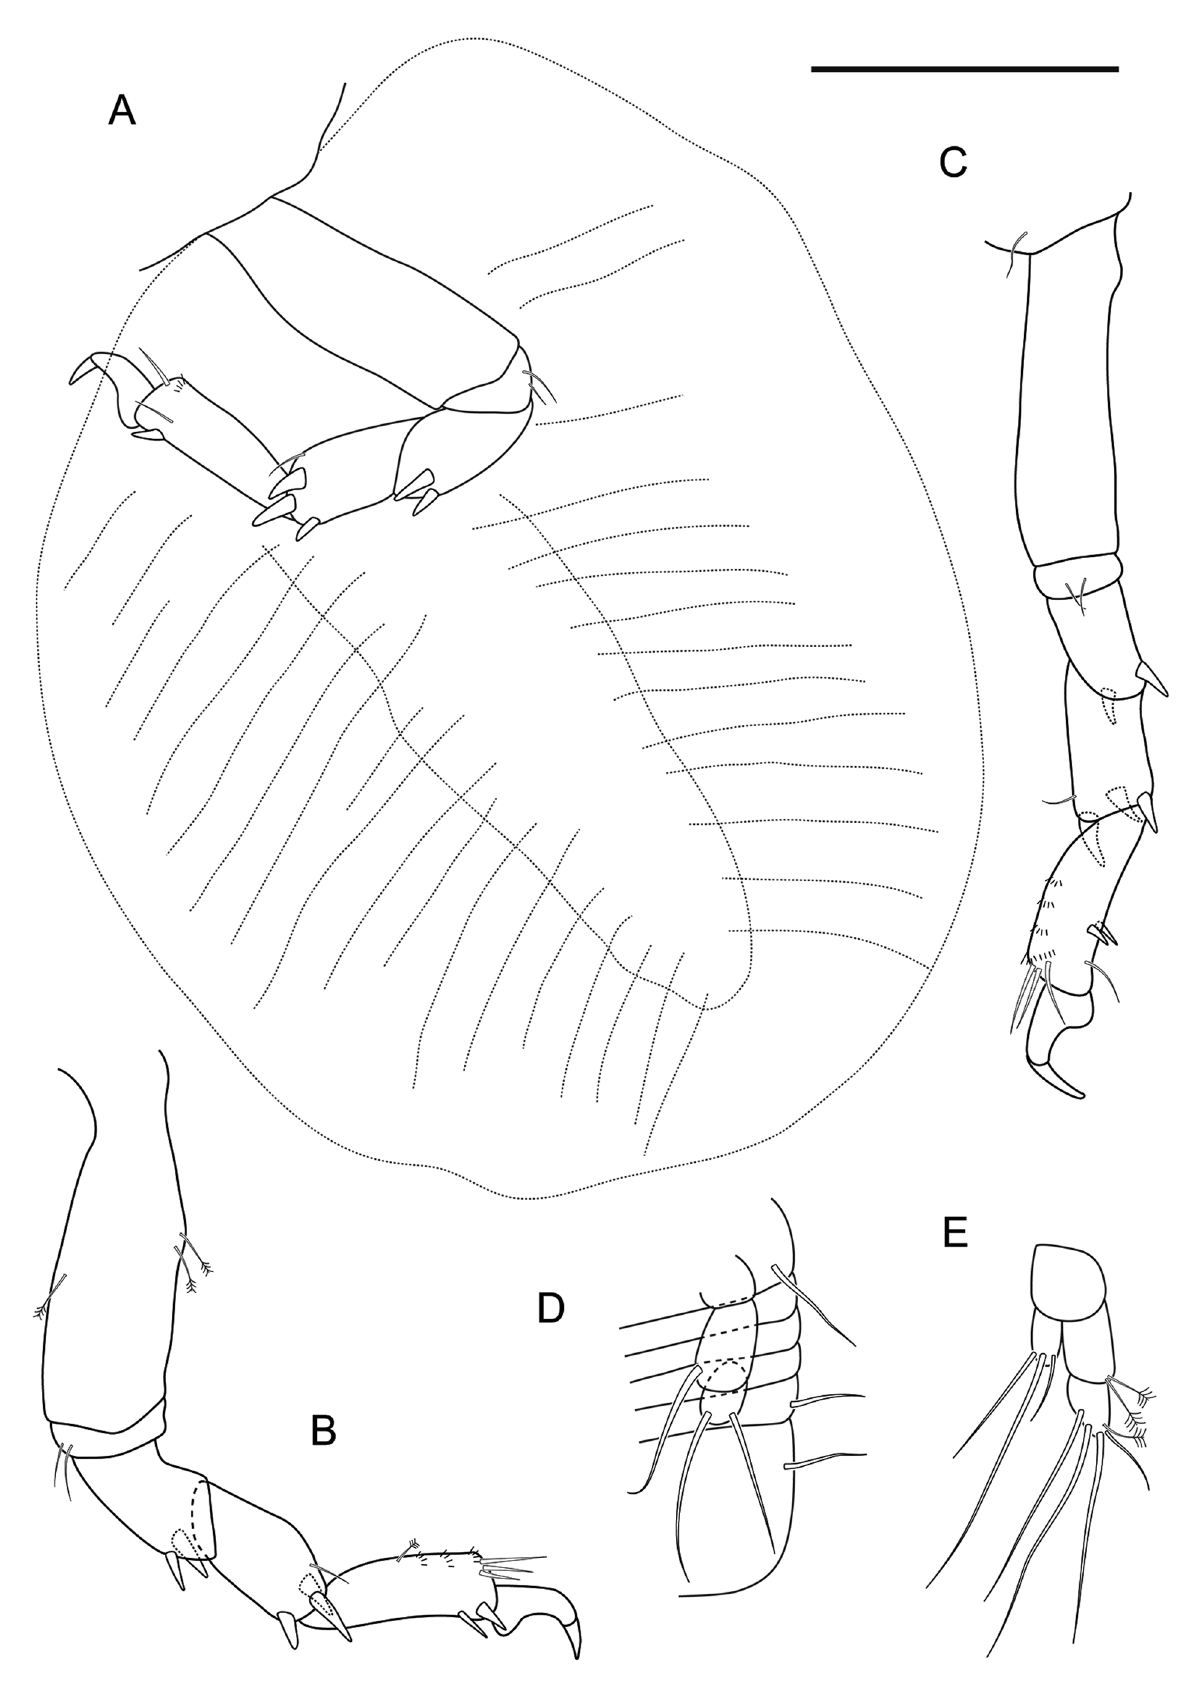
Figure 12. Pseudozeuxo fischeri sp. nov. Paratype, female dissected (MNRJ 29869). A Pereopod-4 with oostegite; B–C pereopods 5–6; D pleopod; E uropod. Scale bar: 0.1